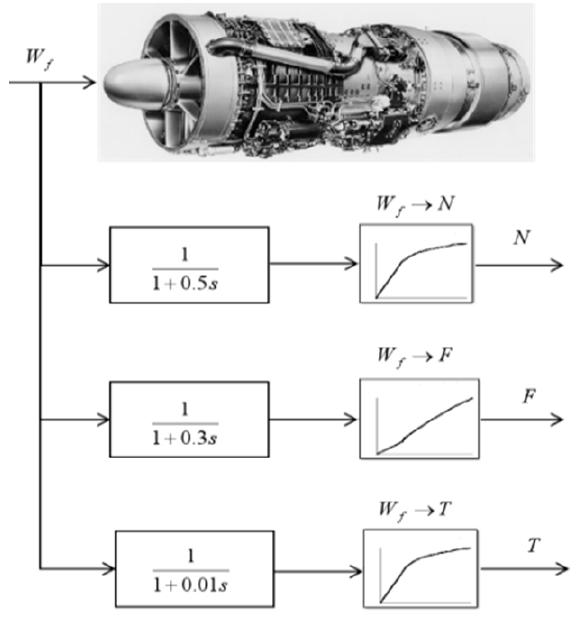
Figure 13. Wiener model for an AVON engine.